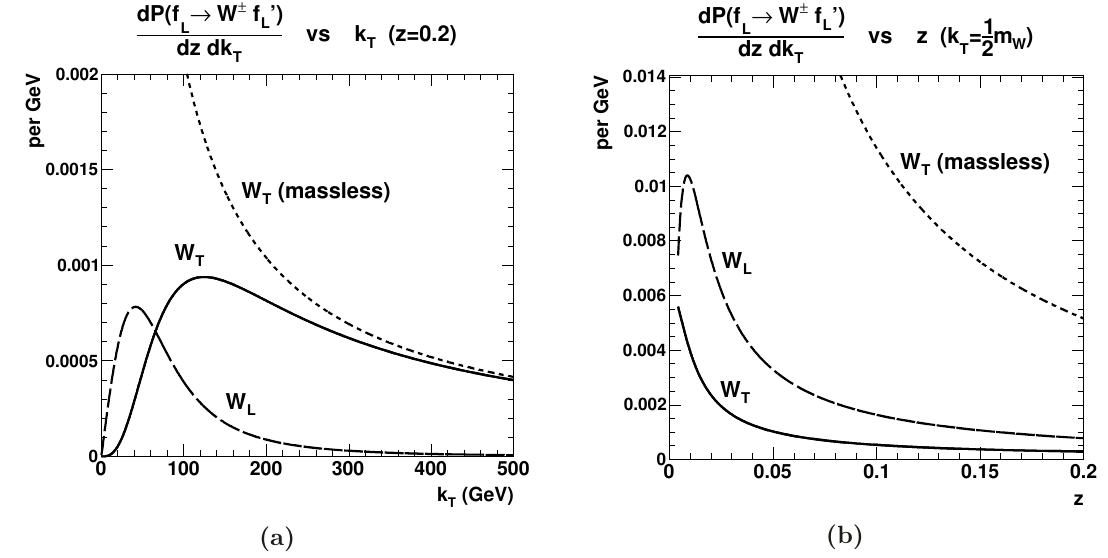
Figure 2. Fixed-order differential emission rate for W ± bosons off a massless fermion at E f = 10 TeV: (a) k T distribution at z = 0 . 2, (b) z distribution at k T = m W / 2. The different curves correspond to massless transversely-polarized W ± W ± (solid curves), and massive longitudinally-polarized W ± T